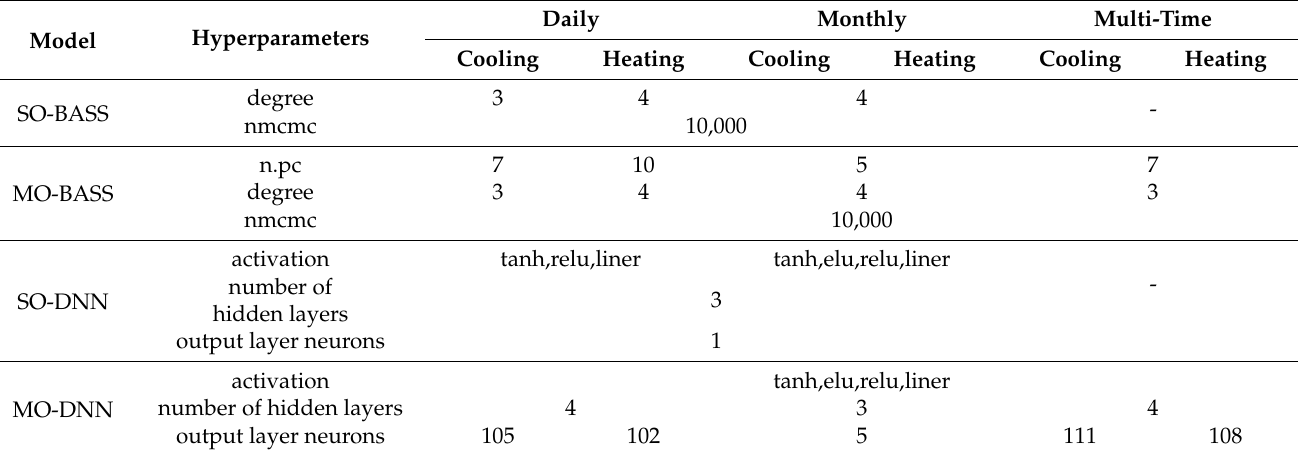
Table 2. The optimal tuning parameters from machine learning